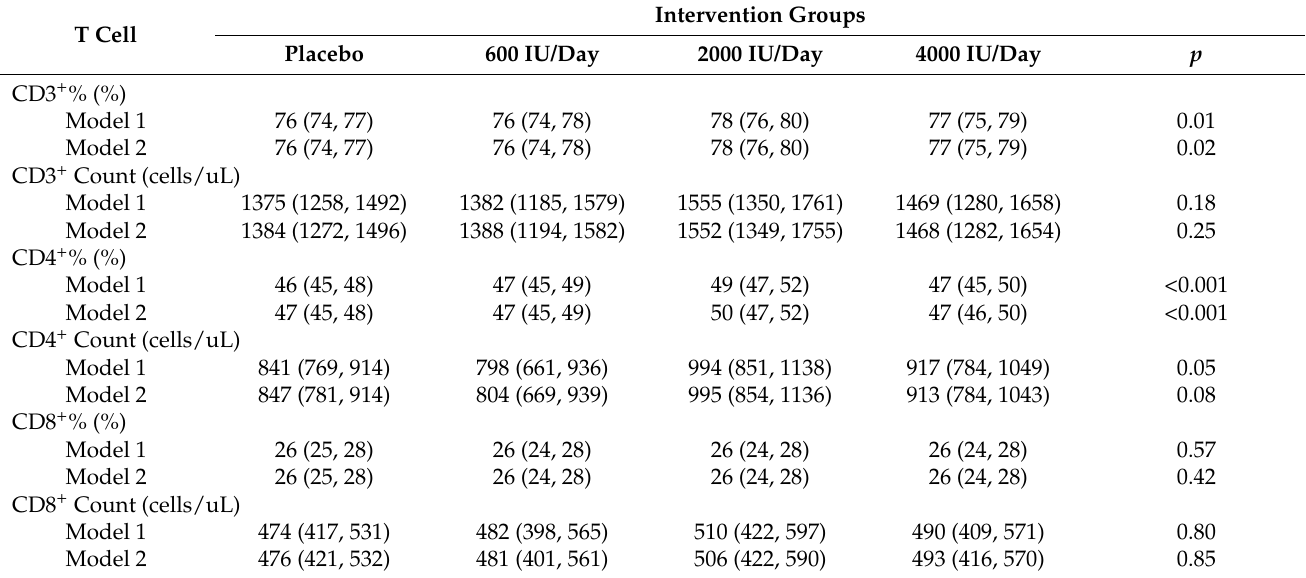
Table 2. Associations between vitamin D supplementation and T